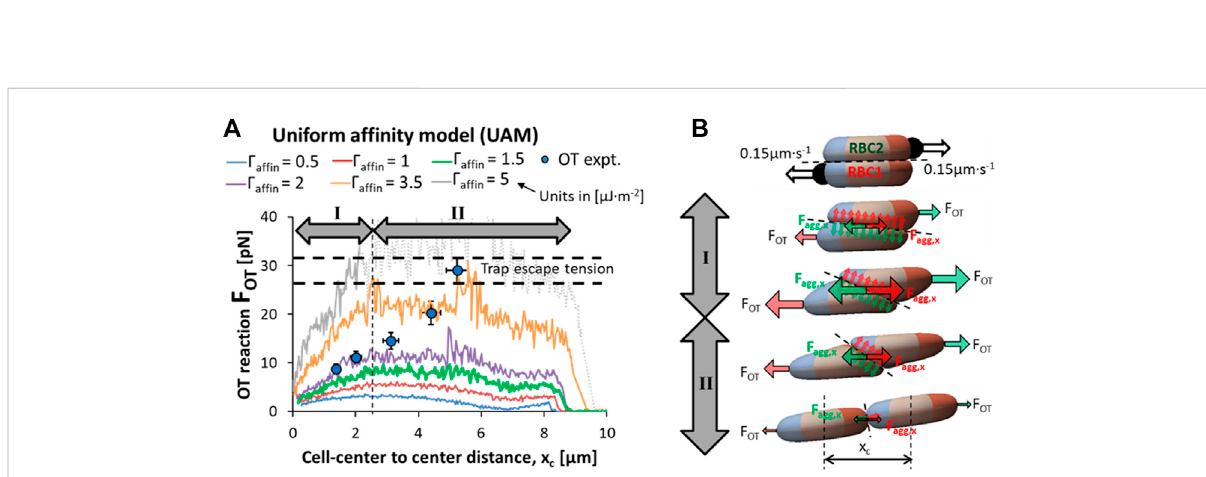
FIGURE 5 Failure of the UAM to recapitulate optical tweezers (OT) experiment results. (A) Comparison of the force-displacement response in OT-driven doublet disaggregation predicted by the uniform af fi nity model (UAM) against the experimental results highlights the failure of UAM to match experimental phenomenon ( simulation movie in SM4 ) (B) A force-balance schematic of the RBC doublet disaggregation with OT showing the simultaneous reorientation of the adhesion plane and contact area loss contributing to the increasing tension stage (stage I) and reducing tension stage (stage II) of the disaggregation.